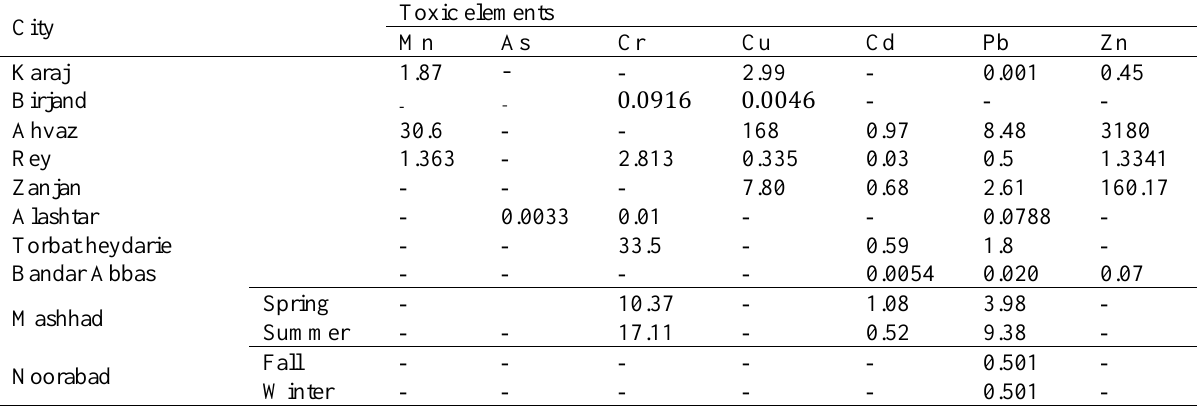
Table 4. Most important parameters and most polluted